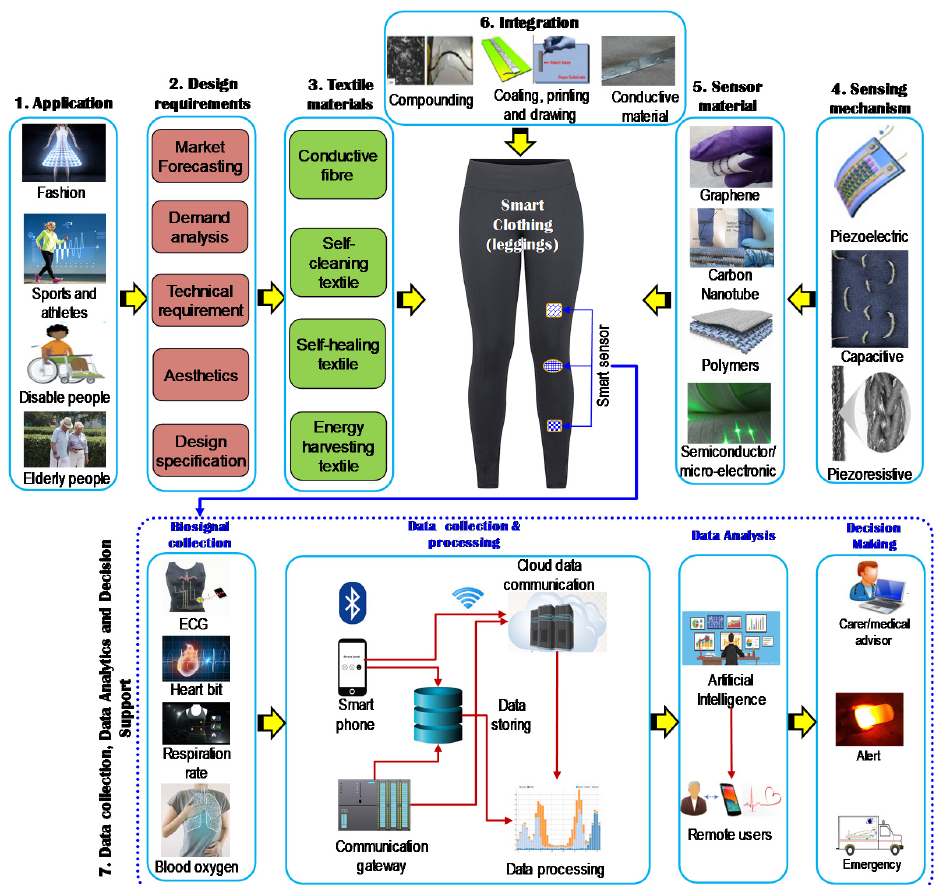
Figure 8. A proposed framework for developing smart clothing (e.g., leggings) for health and fitness monitoring.